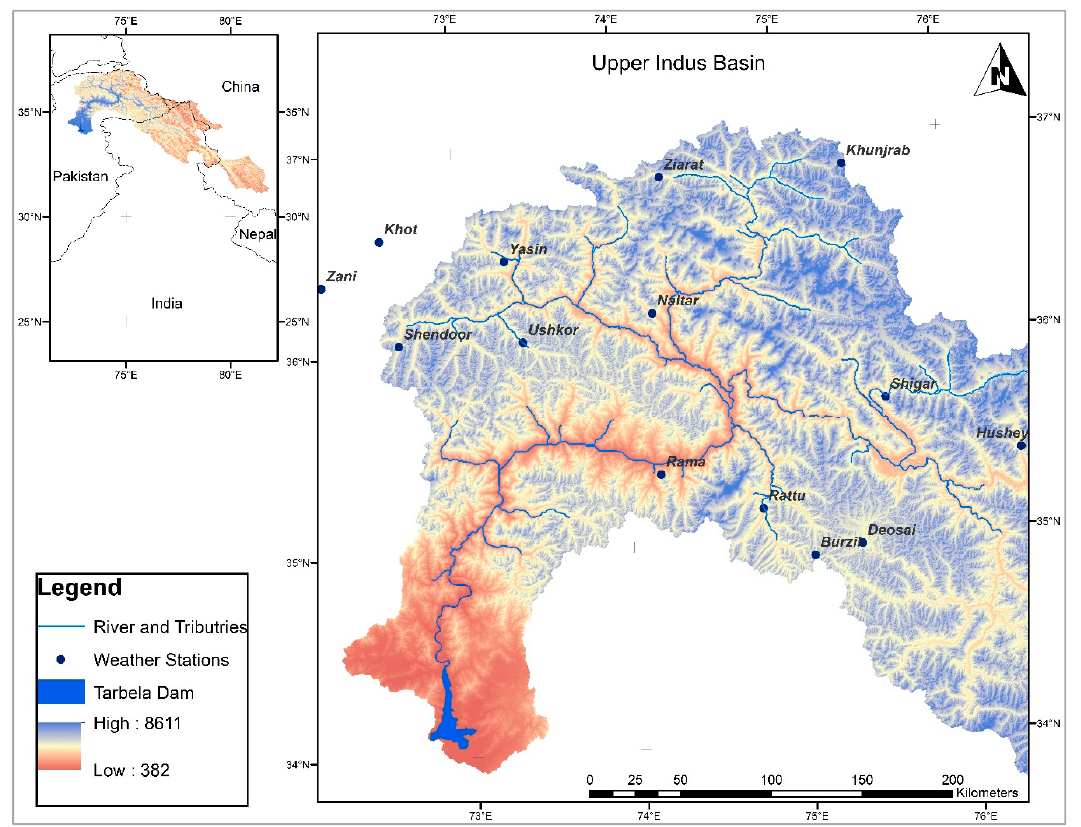
Figure 1. Upper Indus Basin with locations of hydro-climatological stations.